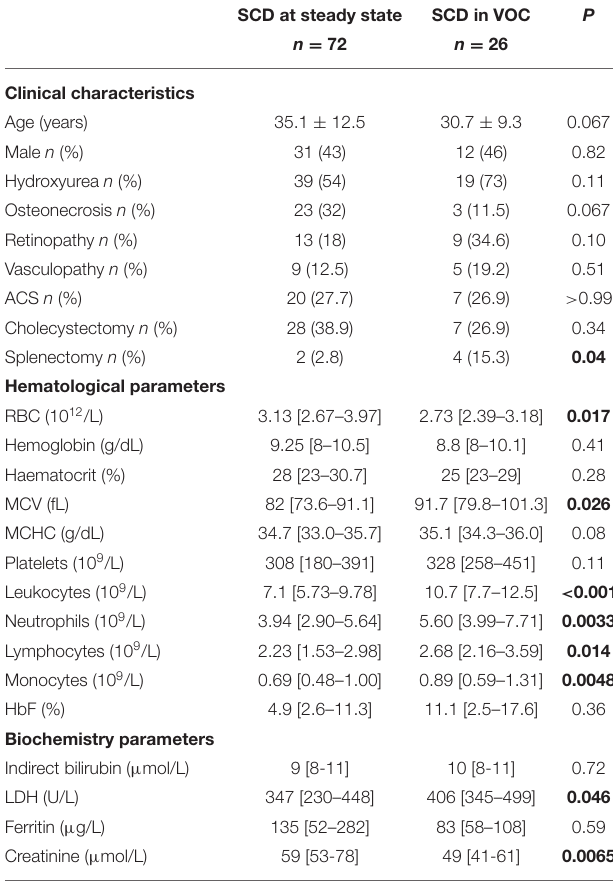
TABLE 1 | Characteristics of study